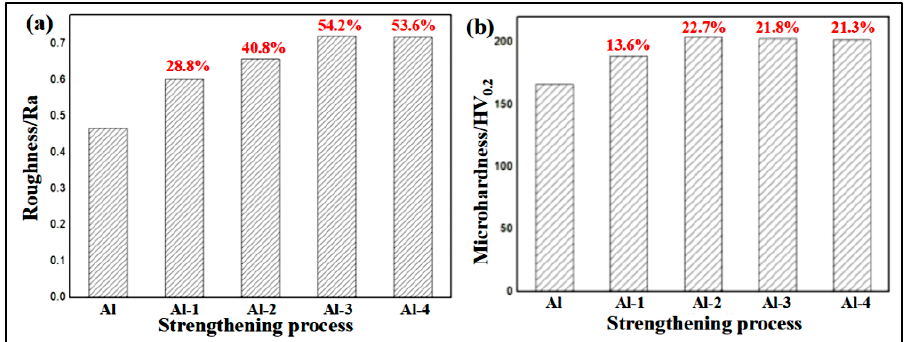
Figure 4. ( a ) Comparison of the roughness of the 7B04 aluminum alloy under different strength- ening processes; ( b ) Comparison of the microhardness of the 7B04 aluminum alloy under different strengthening processes.